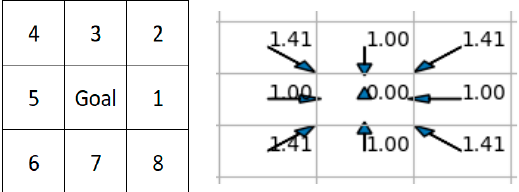
Figure 1. Goal and its eight neighbors ( left ) and shortest distance of the neighbor cells to goal ( right ). We store the information for each cell, such as the center of the cell, the shortest length from the center of the cell to the goal, the optimal moving direction for the cell, and flags, to show the information, such as whether the cell is (1) in an obstacle, (2) already visited, or (3) in the priority queue (PQ).